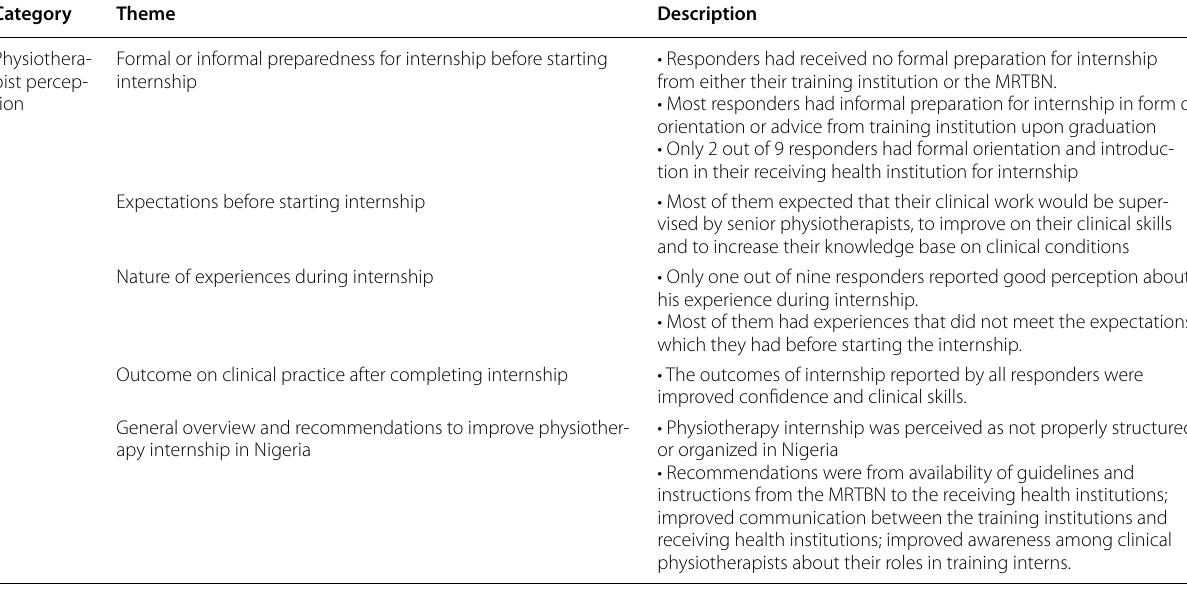
Table 3 Themes and descriptions from the study